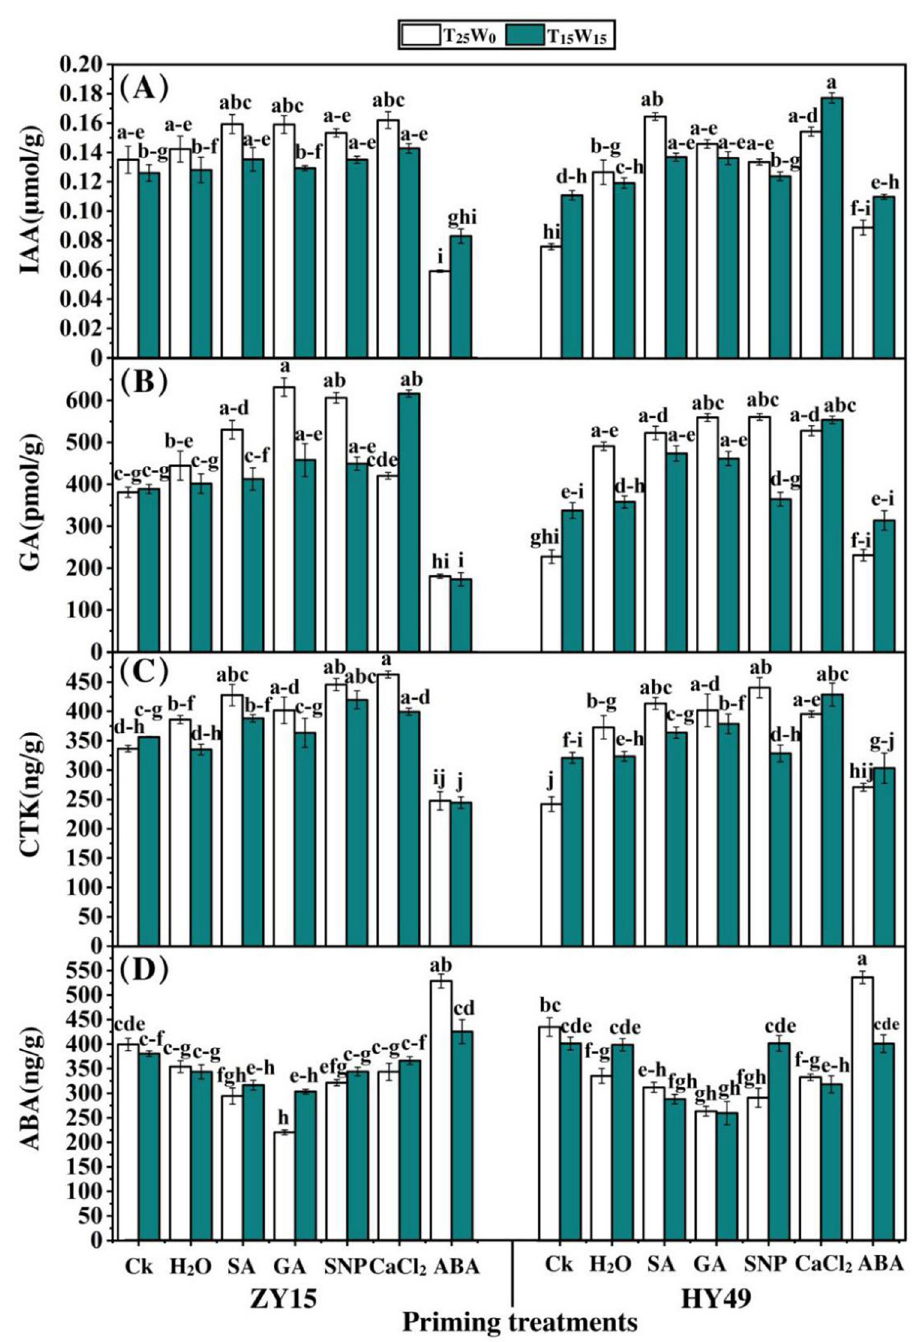
Fig 5. Influence of priming on the hormones of rape seedlings under low temperature and drought conditions. Effects of low temperature and drought stresses (25˚C and 0 MPa, 15˚C and -0.15 MPa) on the hormones: ( A ) indoleacetic acid (IAA), ( B ) gibberellic acid (GA), ( C ) cytokinin (CTK), and ( D ) abscisic acid (ABA) of Brassica napus seedlings (varieties ZY15 and HY49). Seven different treatments, namely, ( a ) control (Ck), ( b ) water (H 2 O), ( c ) salicylic acid (SA), ( d ) gibberellic acid (GA), ( e ) sodium nitroprusside (SNP), ( f ) calcium chloride (CaCl 2 ), and ( g ) abscisic acid (ABA), were evaluated. Each point represents the mean of three replicates. The values presented are the mean ± standard deviation (SD). Significant differences among treatments were determined by a three-way analysis of variance (ANOVA) (p < 0.05 according to Duncan’s multiple range tests).